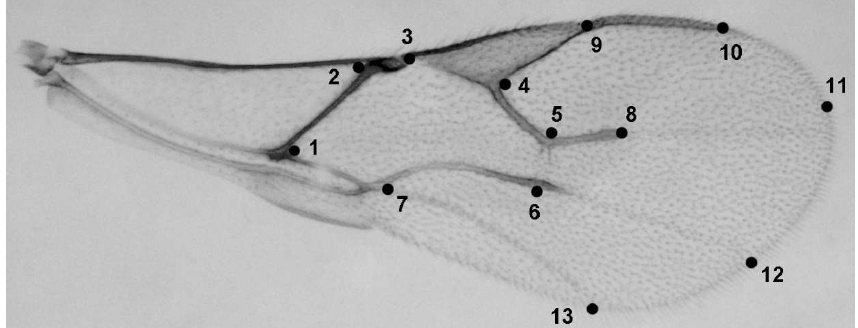
Fig. 2. Landmarks scored on a left forewing of Aphidius absinthi